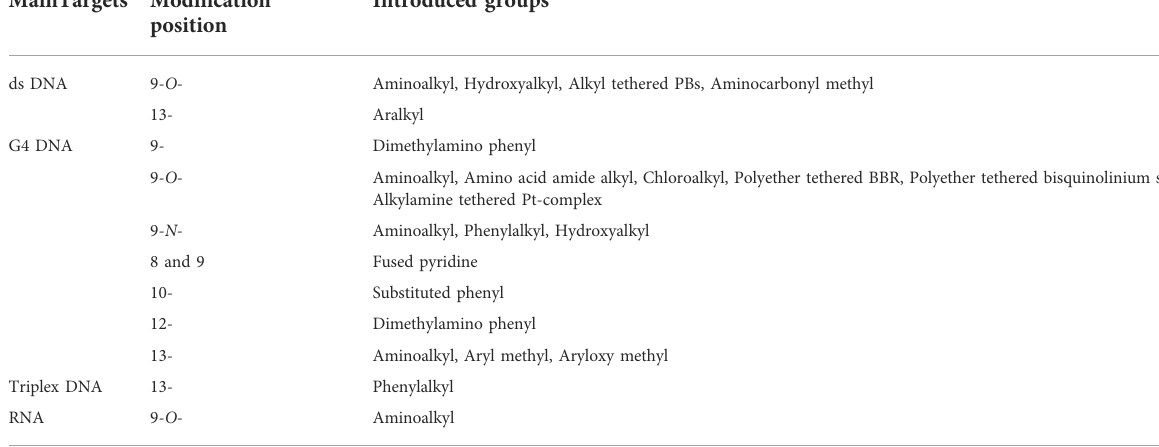
TABLE 1 The main modi fi cation strategies of BBR towards polymorphic DNAs. MainTargets Modi fi